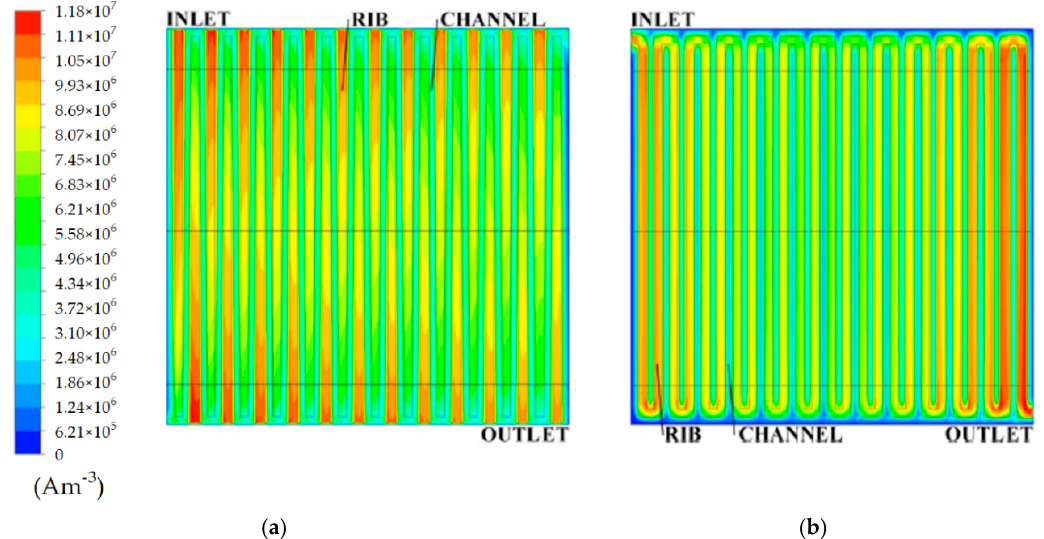
Figure 9. Distribution of reaction rates in a plane at the half-height of the electrode with: ( a ) Single serpentine geometry; ( b ) Interdigitated geometry [101].